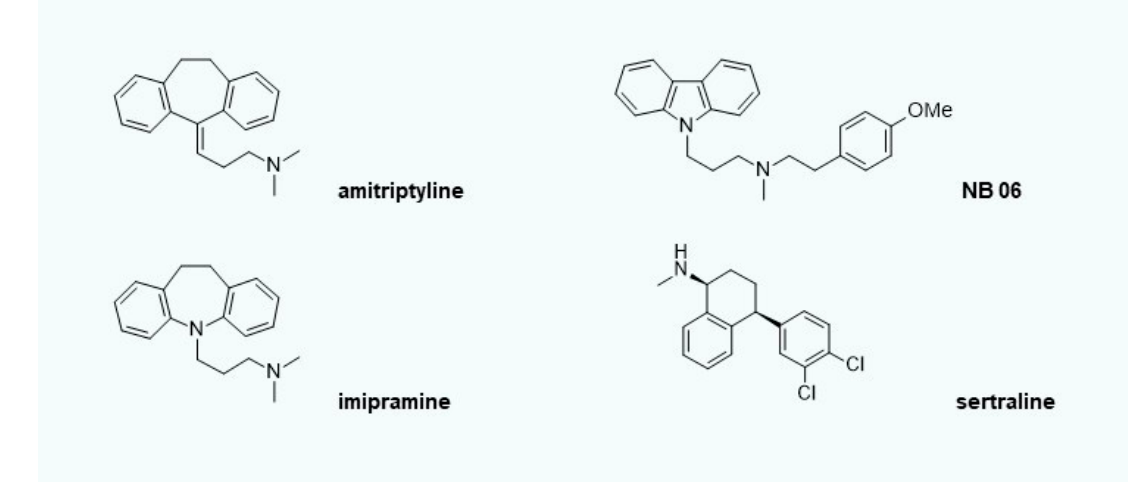
Figure 5. Lysosomotropic compounds amitriptyline, imipramine, sertraline, and the model compound NB 06 [32,36].